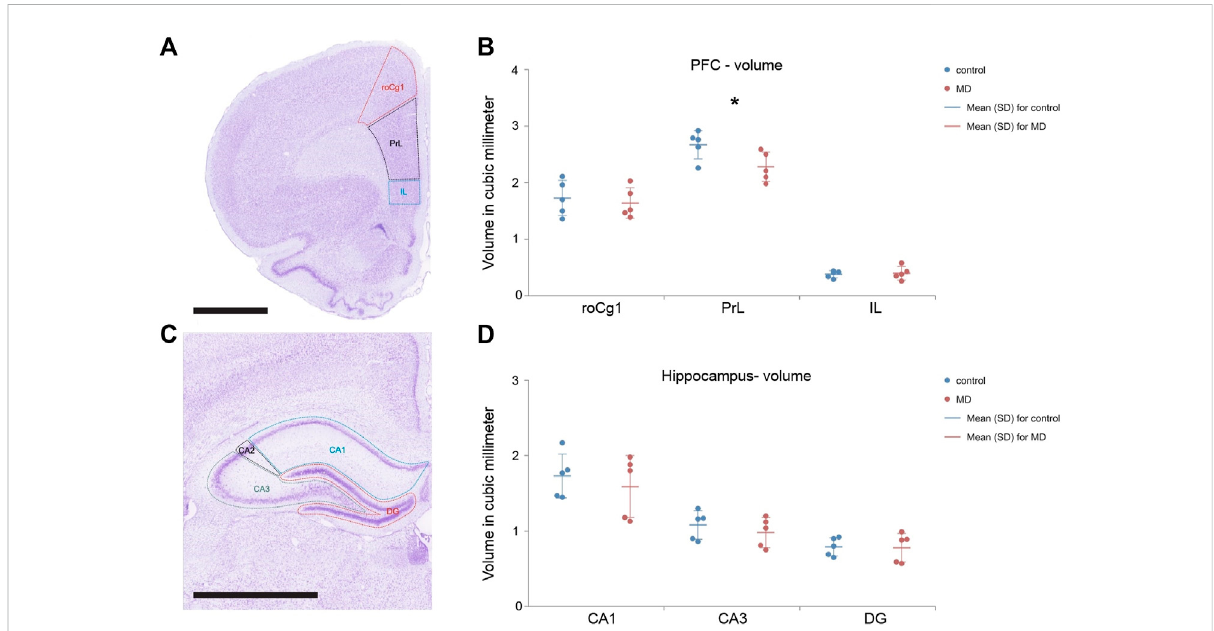
Total volume of the mPFC and hippocampus divided into sub fi elds. Representative micrograph of the cresyl violet stained section of the mPFC divided into sub fi elds roCg1, PrL and IL (A) and hippocampus divided into sub fi elds CA1, CA3and DG (C) with delineated regions for volume analysis. Dotplotgraphs representsquanti fi cationoftheresultsasmeans±SD(horizontalbars)andobservedvalues(dots)intherespectivethemPFC (B) and hippocampus (D) .MDratshaddecreasedvolumeofthePrLcomparingtoControl, *p < 0.001.Hippocampalsub fi eldsCA1(CA1),CA2(CA2),and CA3 (CA3), rostral part of area 1 of cingulate cortex (roCg1), dentate gyrus (DG), infralimbic cortex (IL), prelimbic cortex (PrL). Scale bar = 2